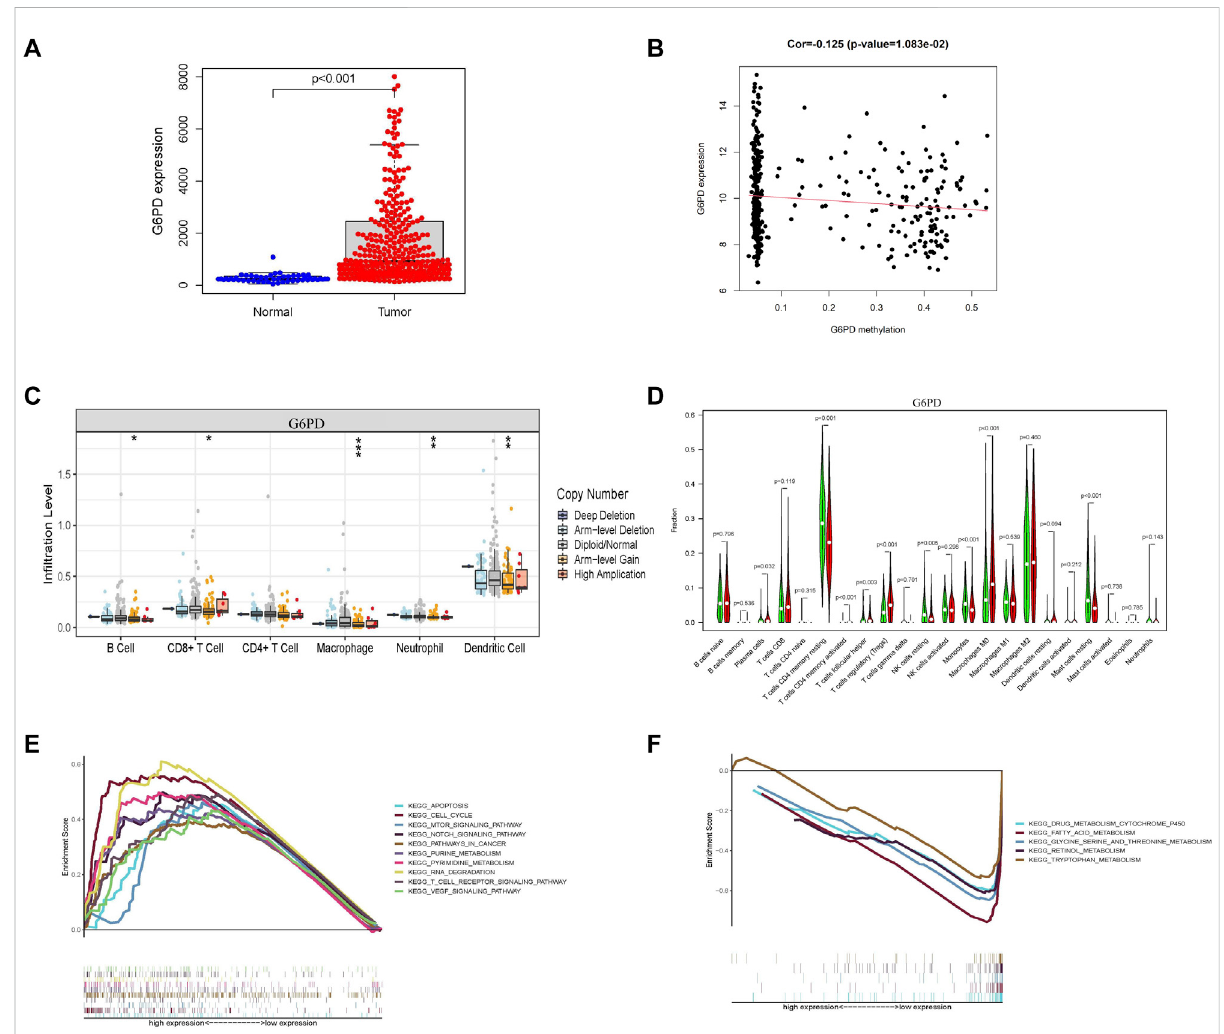
FIGURE 7 Characterization of G6PD as a hub gene related to glycometabolism-related risk score. (A) G6PD mRNA expression in tumor and normal tissues. (B) Correlation between G6PD expression level and its methylation level. (C) Differences in copy number variation of G6PD in different immune cells. (D) Comparison of immune in fi ltrating cells between high and low G6PD expression groups. (E,F) Multi-GSEA of KEGG pathway enrichment in high and low G6PD expression